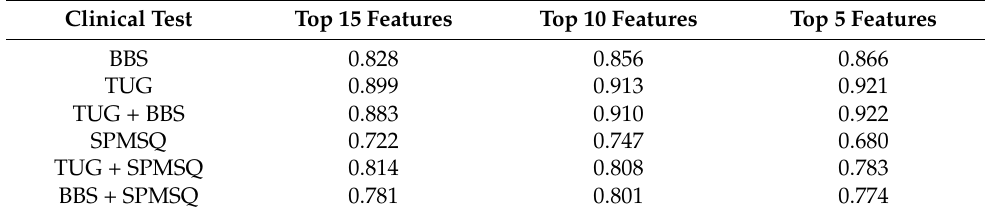
Table 5. RF mean AUC scores for each clinical test.